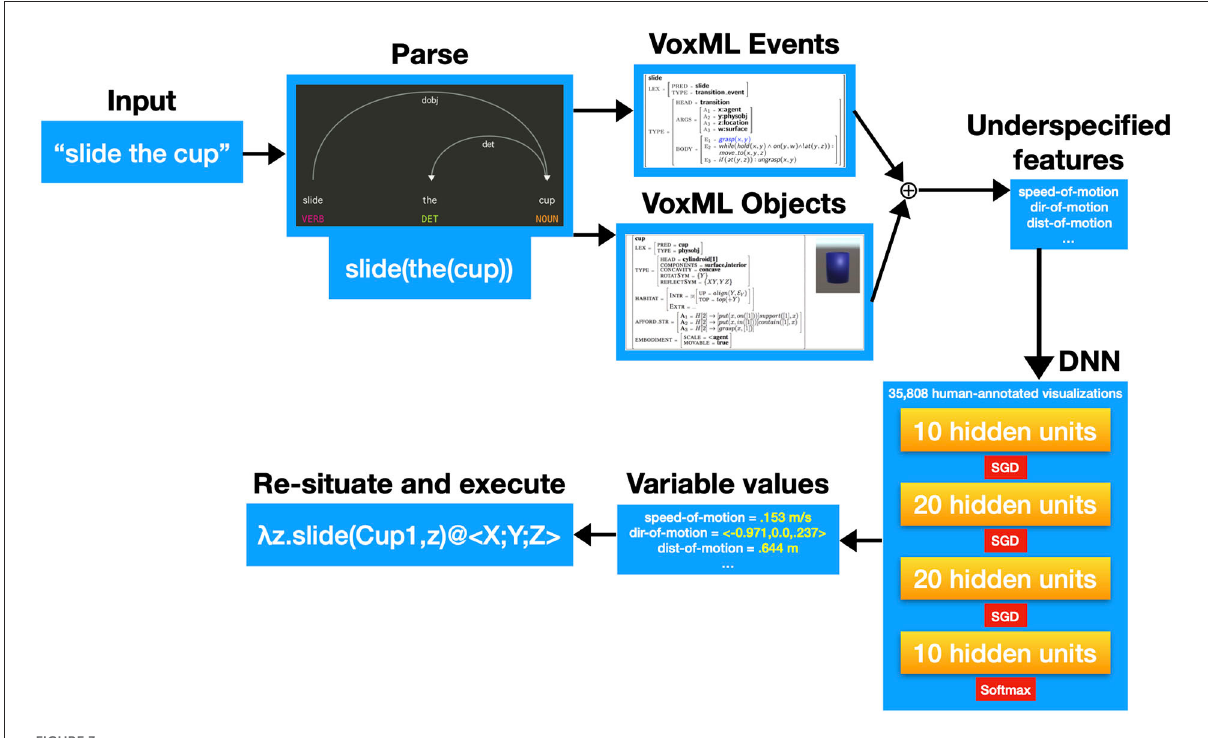
FIGURE3 Pipeline for generating multimodal